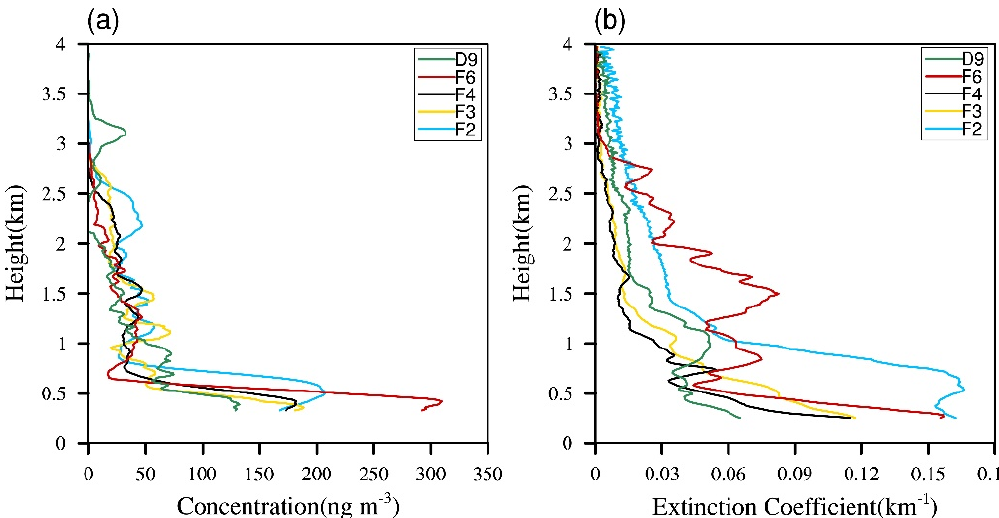
Figure 7. The ( a ) vertical profiles of BC concentration simulated by FLEXPART-WRF at monitoring sites F2, F3, F4, F6, and D9; and the ( b ) vertical profiles of the extinction coefficient at monitoring sites F2, F3, F4, F6, and D9. Table 4. Correlation coefficient between vertical concentration profile and extinction coefficient pro- file at monitoring sites F2, F3, F4, F6, and D9.